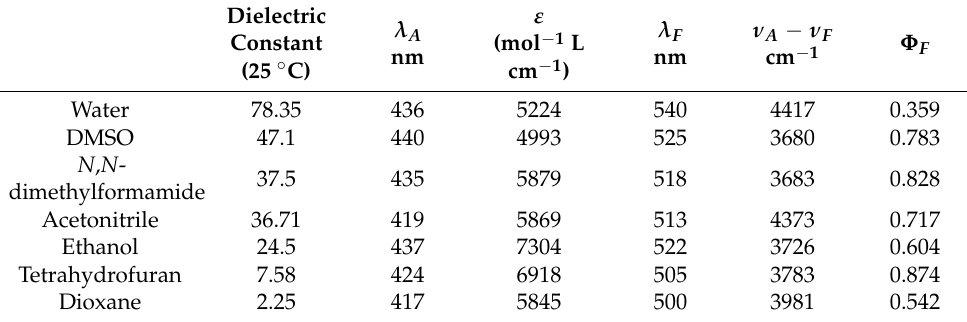
Table 1. Photophysical characterization of NI-DAT in various organic